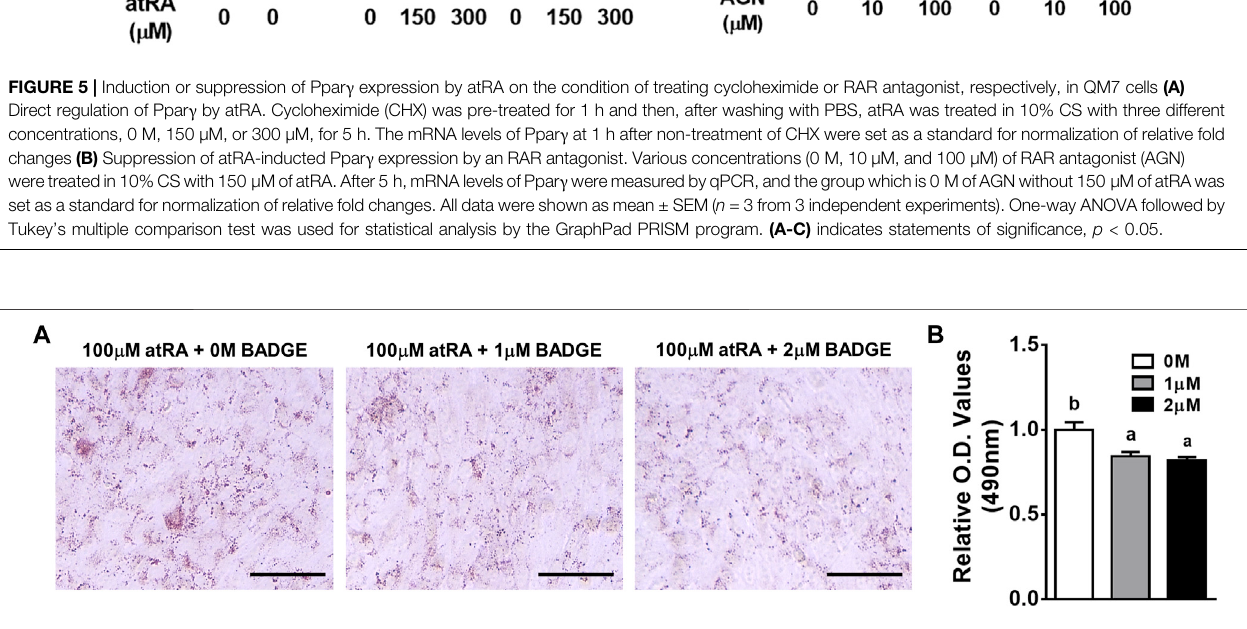
FIGURE 6 | Effects of BADGE as an inhibitor of atRA-induced lipid accumulation in QM7 cells. Oil-Red-O (ORO) staining (A) and O.D. values (B) . QM7 cells were grown in different concentrations of BADGE (0 M, 1 μ M, or 2 μ M) in 10% CS with 100 μ M of atRA for 2 days, and then assessed for lipid accumulation. Lipid droplets in cellswerevisualizedunderamicroscopeafterOROstainingandquanti fi edbyarelativeamountofOROpercellwhichisnormalizedbyagroupofthe0 MBADGE.Scale bar: 100 μ m. All data were shown as mean ± SEM ( n = 3 from 3 independent experiments). One-way ANOVA followed by Tukey ’ s multiple comparison test was used for statistical analysis by the GraphPad PRISM program and statements of signi fi cance noted by a-b are based on testing at p < 0.05.